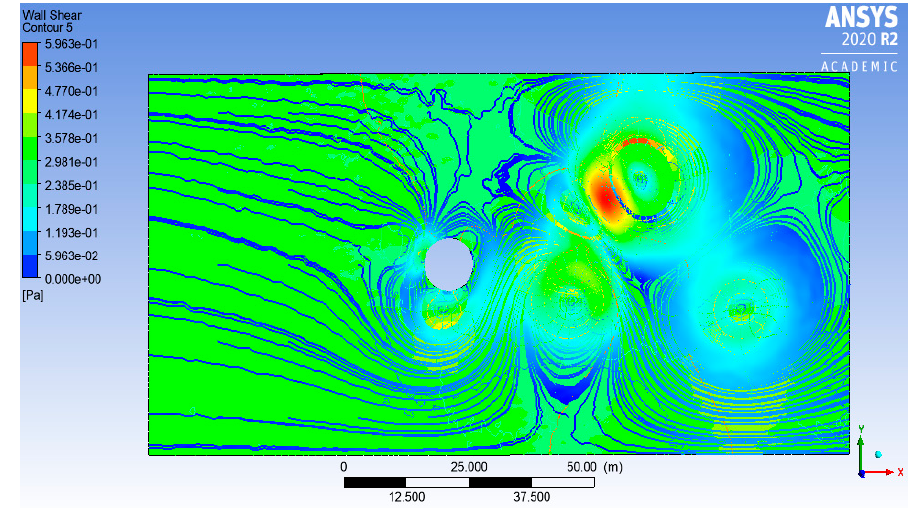
Figure 18. Wall shear contour for the flow on the free-floating buoy under case 0.45 m/s.